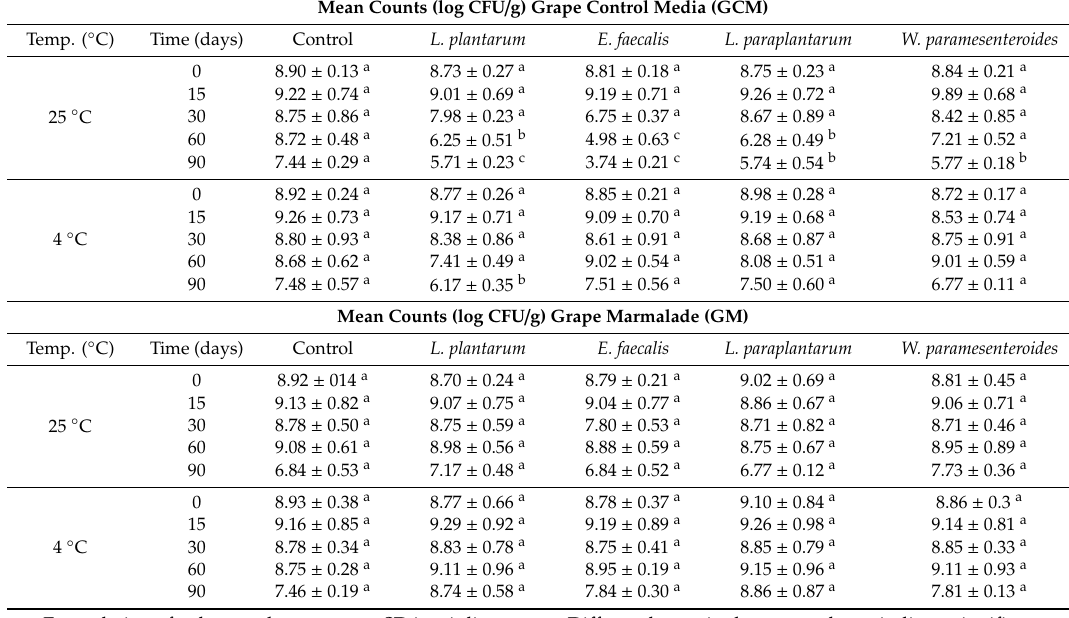
Table 3. LAB counts (log CFU / g) for the non-inoculated and inoculated GCM and GM kept at room and refrigerated